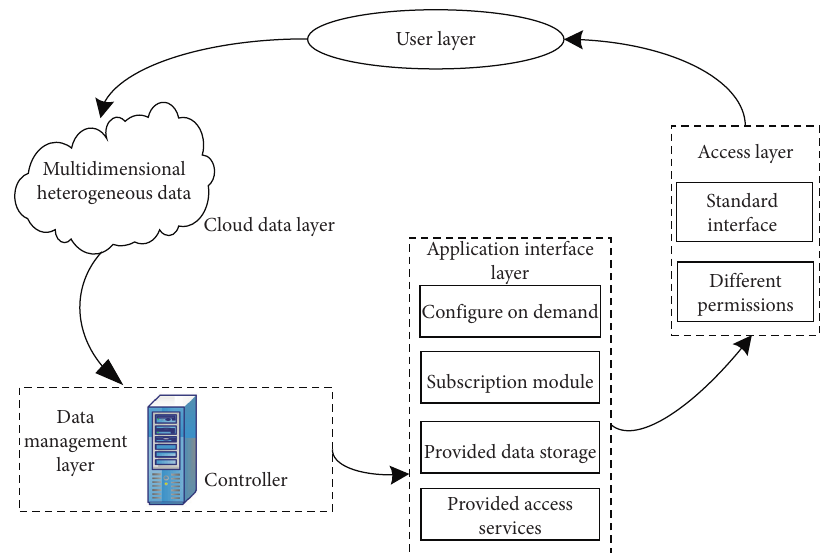
Figure 1: Logical architecture of intelligent cloud collaboration management system.